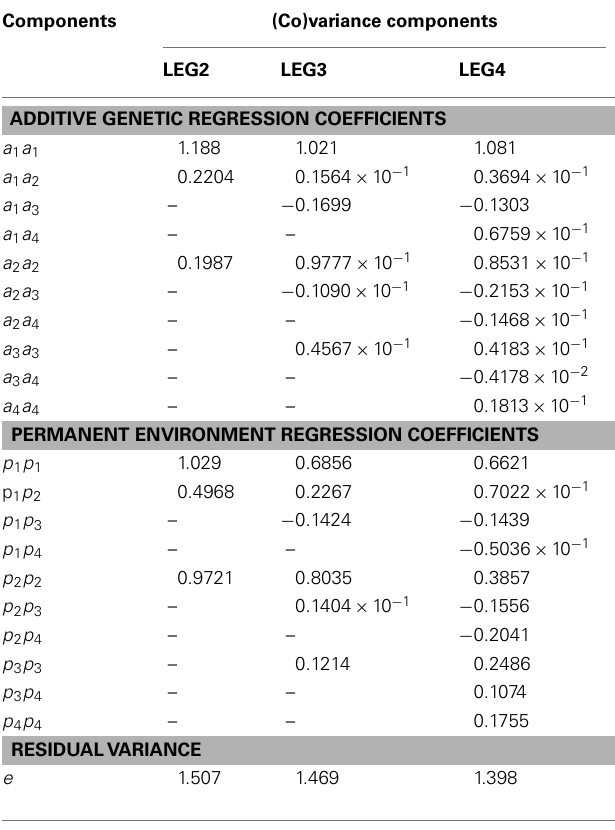
Table 4 |Additive genetic, permanent environment and residual (co)variance estimates of the regression coefficients, obtained using different random regression models.